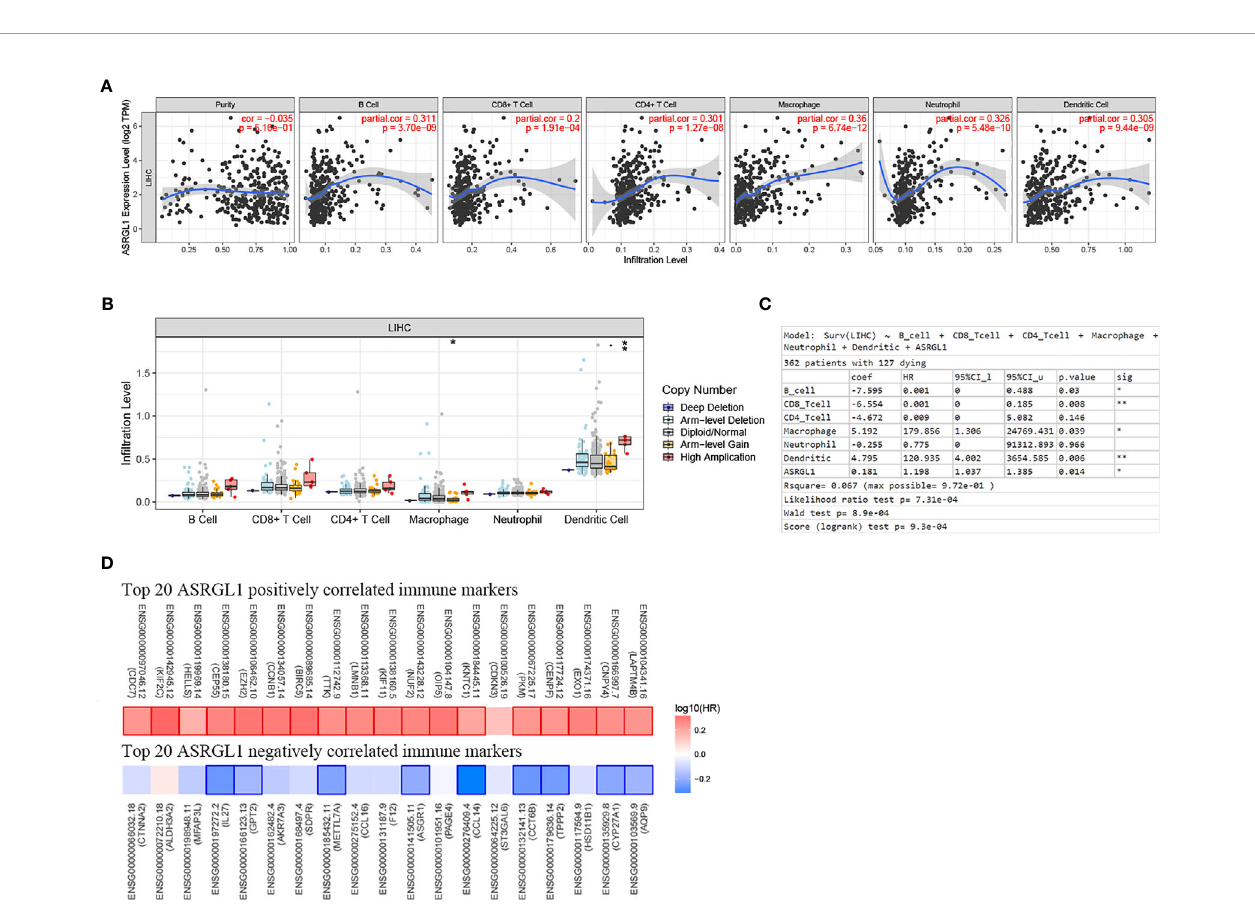
FIGURE 7 | Correlation between the mRNA expression of ASRGL1 and the immune in fi ltration in HCC. (A) The signi fi cant correlation between ASRGL1 mRNA expression and in fi ltrating levels of B cells, CD4+ T cells, macrophages, neutrophils, and dendritic cells in HCC. (B) The effect of ASRGL1 CNV on the in fi ltrating levels of macrophages, and dendritic cells in HCC. (C) Evaluation of the impact of ASRGL1 expression on overall survival in the presence of in fi ltrating levels of multiple immune cells using multivariable hazards models. (D) Survival maps of the top 20 positively and negatively genes correlated with the immune markers in HCC, respectively. *p < 0.05, **p <